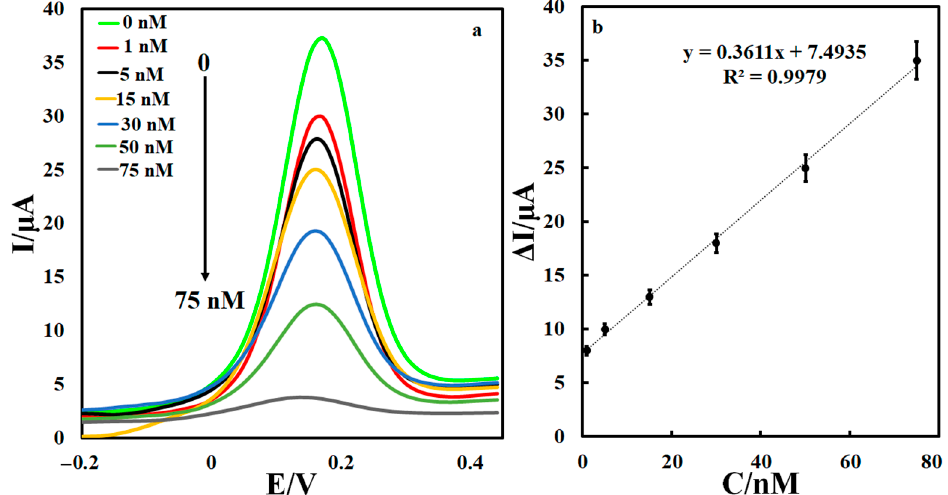
Figure 7. ( a ) Electrochemical aptasensor responses towards different concentrations of epirubicin, ( b ) calibration curve.